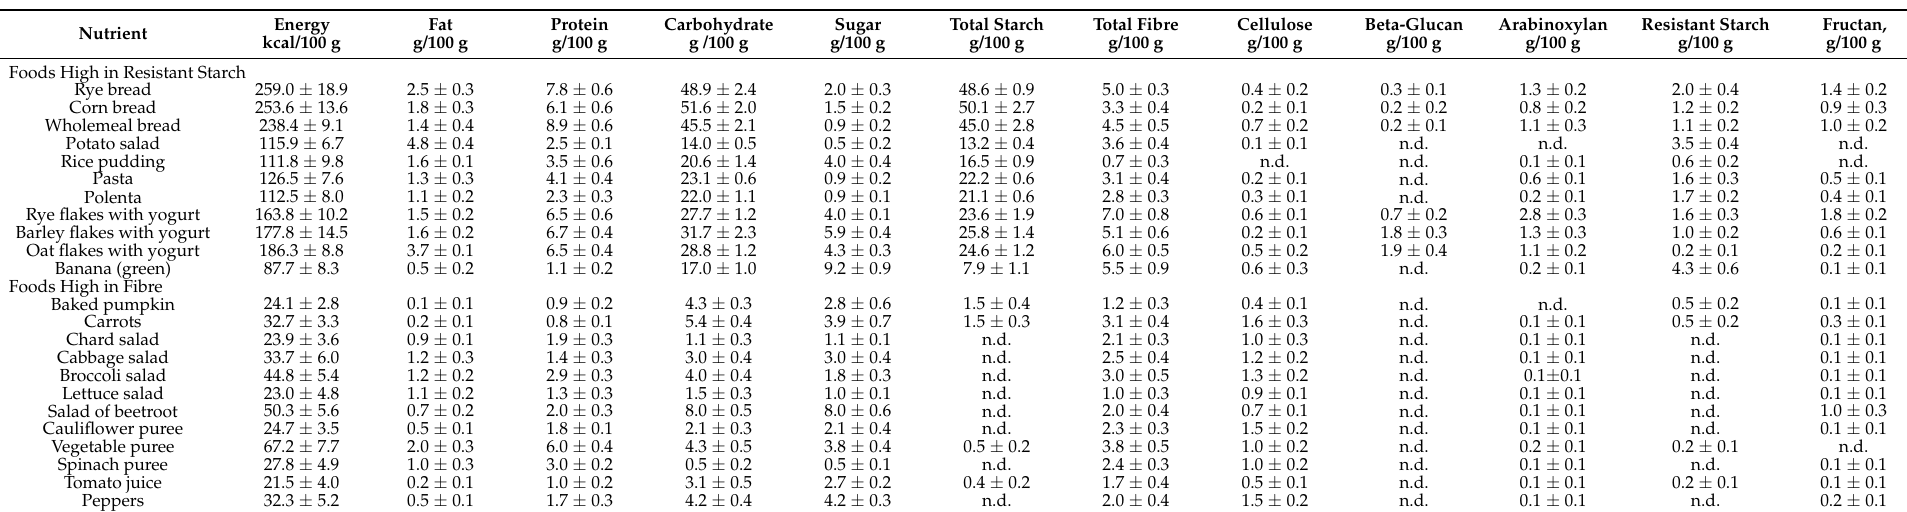
Table 2. Recommended fibre/resistant starch-rich foods in the dietary